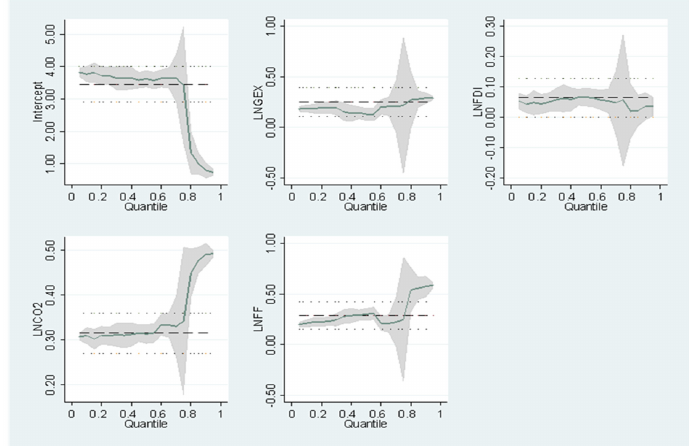
Figure 3. PQR-North. Figure 3.